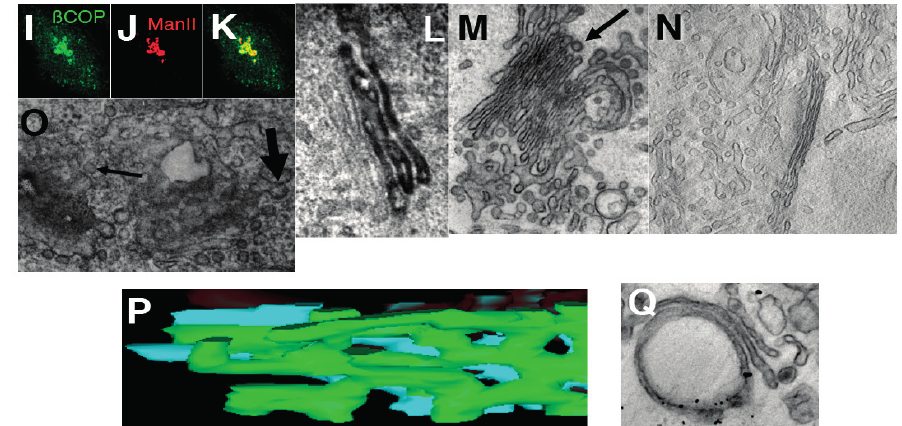
Figure 5. The Golgi tubulation induced by brefeldin A (BFA) depends on the availability of coatomer I-dependent (COPI) vesicles. ( A ) Incubation of isolated Golgi membranes for 90 min, always in the presence of the ARS, GTP, with the normal cytosol (Cyt (+COPI)), blue) or COPI-depleted cytosol: Cyt ( − COPI)), without or with isolated COPI vesicles (Vesicles), the mutant of α SNAP ( α SNAPmu) and/or BFA, as indicated below the graph. The degree of tubulation was estimated as indicated in Supplementary Materials. Red, low level of tubulation before incubation; ( B ) Incubation of Golgi membranes with COPI-depleted cytosol in the presence of ARS/GTP for 90 min transforms Golgi cisternae into tubules, although only partially (orange bar in A ). Tubulation was not seen if α SNAPmu was added to the incubation medium (green bar in A ); ( F ) Incubation of the Golgi membranes as in ( B ), but in the presence of isolated COPI vesicles (magenta bar in A ). Higher degree of tubulation. Addition of α SNAPmu to incubation medium as in ( F ) blocked tubulation (brown bar in A ); ( G ) BFA (2 µg/mL for 90 min) induced tubulation of isolated Golgi membranes in the presence of externally added COPI-dependent vesicles (white bar in A ), and not in their absence (black bar in A ), or when added together with the vesicles. When α SNAPmu was added, this tubulation was also blocked ( H , light blue bar in A ); ( C – E ) Isolation of COPI vesicles (arrows) isolated with the help of magnetic beads; ( I – K ) Revesibility of the changes in the Golgi shape. ( I – R ) HeLa cells were treated with NZ (5 min) and then with NZ + BFA (5 min), followed by NZ alone (5 min, B , F ) and then BFA was washed out for 2 min ( I – K , N ) or 5 min ( L , M , O ), ( I – K ) Re-appearance of β -COP labeling (green) over ManII-positive structures (red) 2 min after BFA wash out; ( L , M ) Transformation of Golgi tubules back into polarized stacks of cisternae containing coated buds (thick arrow in O ) and surrounded by 50–60 nm round profiles (arrows in L , M ); ( N ) RPs visible 2 min after BFA washout were sections of varicose tubules; ( O ) Increase of the number of free 52 nm vesicles and COPI-coated buds; ( P ) Re-addition of BFA after reformation of GA (as in L ) induced Golgi tubulation again; ( Q ) Re-appearance of stacked cisternae after treatment of isolated Golgi membranes with COPI-depleted cytosol and ARS/GTP for 90 min (see above), re-isolation of the tubulated Golgi membranes and additional treatment of these membrane with normal cytosol and ARS/GTP for a further 90 min. Bars, 200 nm ( B ); 100 nm ( C , D ); 80 nm ( E ); 200 nm ( F , M , N ); 150 nm ( G , H , L , Q ); 10 µm ( I – K ); 120 nm ( O ); 50 nm ( P